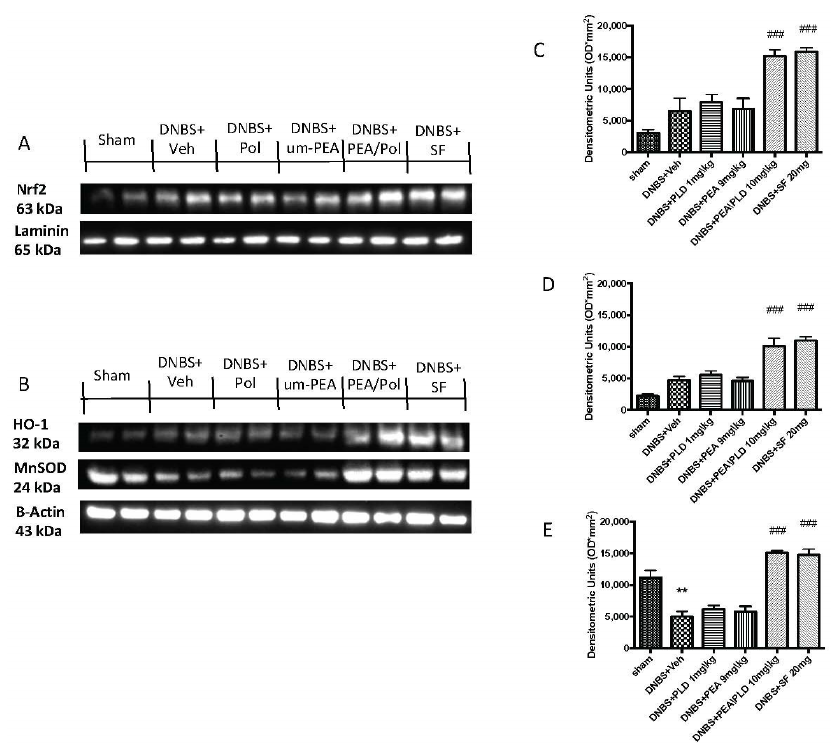
Figure 7. Western blots for Nrf2, HO-1, and manganese superoxide dismutase (MnSOD). Representative Western blots for nuclear Nrf2 translocation ( A ), cytoplasmic HO-1 expression, and cytoplasmic MnSOD expression ( B ) were performed. Densitometric analysis for Nrf2 ( A ), HO-1 ( B ), and MnSOD ( C ) are shown. The results in ( C – E ) = means ± SEM of six animals in each group; ** p < 0.01 vs. sham, ### p < 0.001 vs. DNBS.